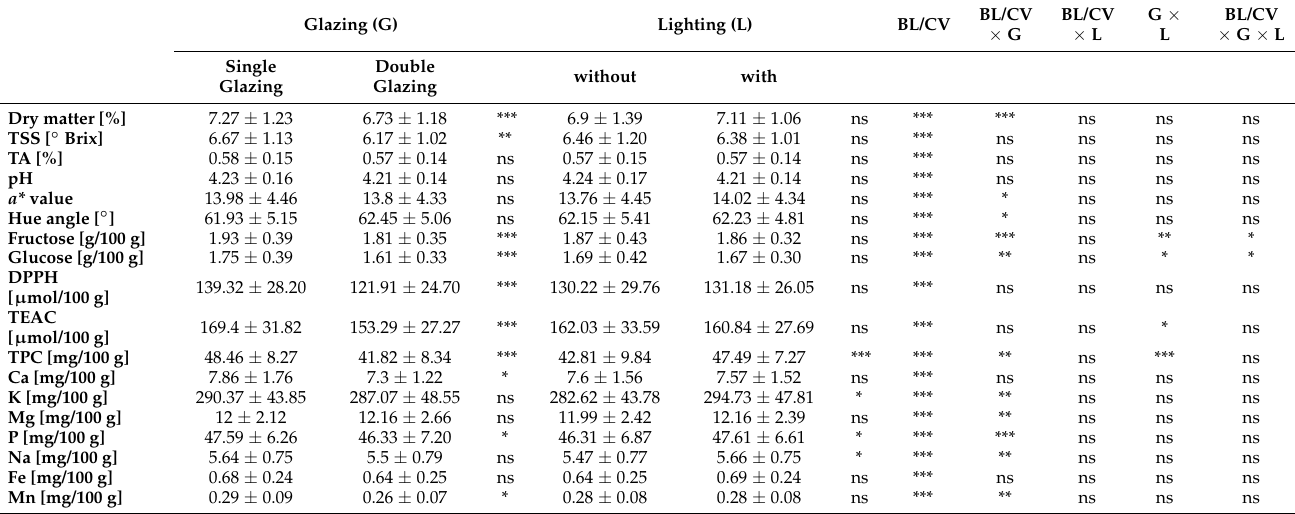
Table 6. Mean values ± standard deviation of quality parameters, fructose and glucose content, antioxidant capacity, total phenolic content, and minerals of five breeding lines and Lyterno F 1 , distinguished between single-glazed and double-glazed greenhouses, or with and without supplementary LED lighting.